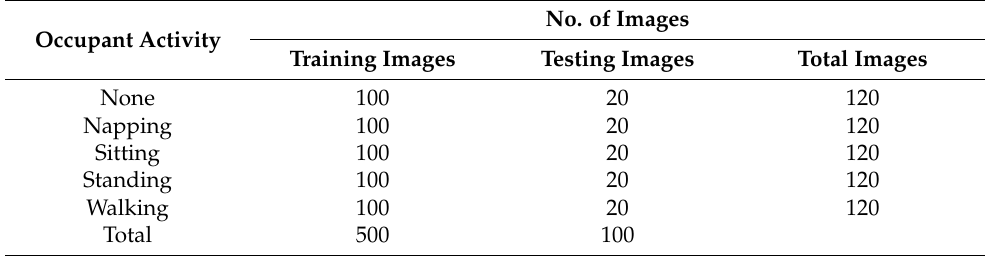
Table 2. The training and testing images for the occupancy activity detection